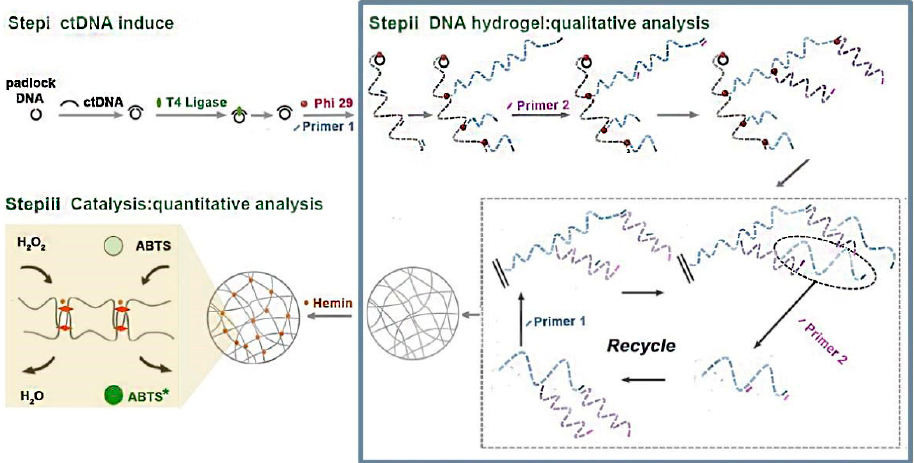
Figure 1. Schematic illustration of pure DNA hydrogels formed by RCA reaction for ctDNA visible detection. Reproduced with permission from Xiaoxia Mao, Sensors and Actuators B: Chemical; published by Elsevier, 2019.